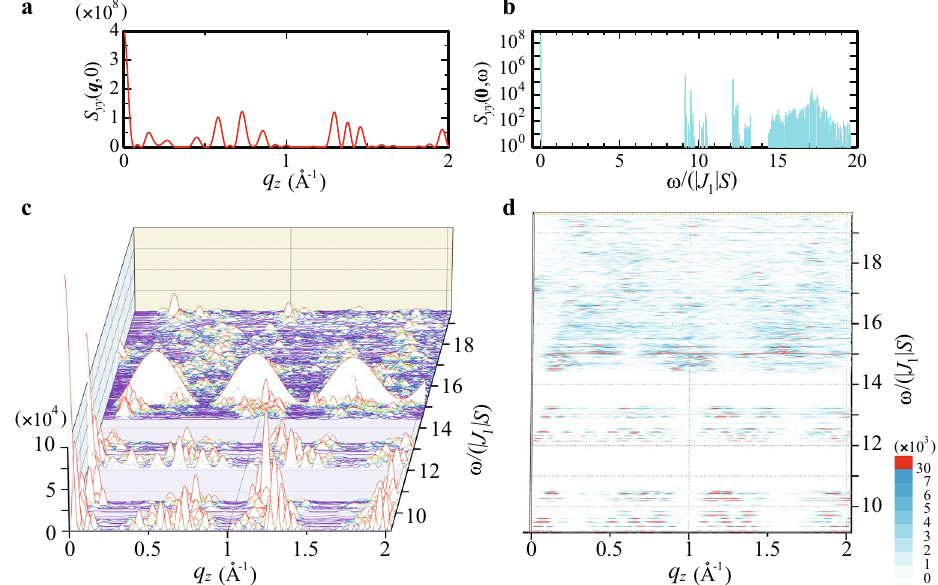
Figure 4. ( a ) Elastic component of the dynamical structure factor S yy ( q , 0 ) for q along the d e ∗ 2 line. ( b ) The ω dependence of the dynamical structure factor S yy ( 0 , ω) . ( c ) The dynamical structure factor S yy ( q , ω) for q along the d e ∗ 2 line. ( d ) Top view of ( c ). (This figure is created by using Adobe Illustrator CS5 Version